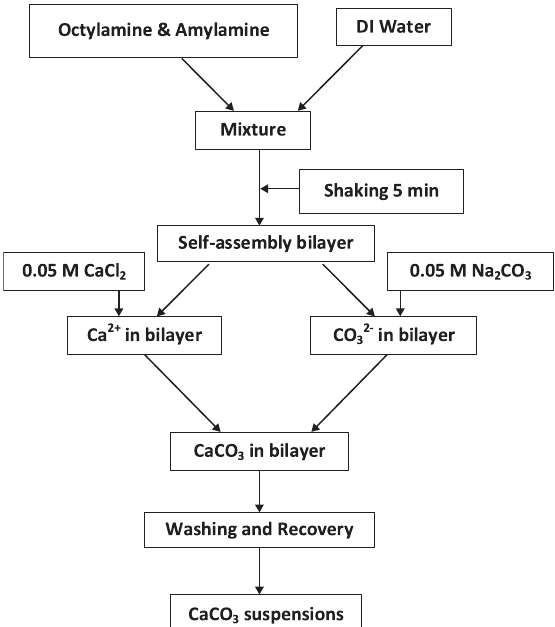
Fig. 1 Flow sheet of CaCO 3 particles synthesized from octyl- amine/water bilayer systems. The pH of the bilayer is controlled at pH 10. The octylamine to amylamine weight ratio is 25 (Yener et al.,